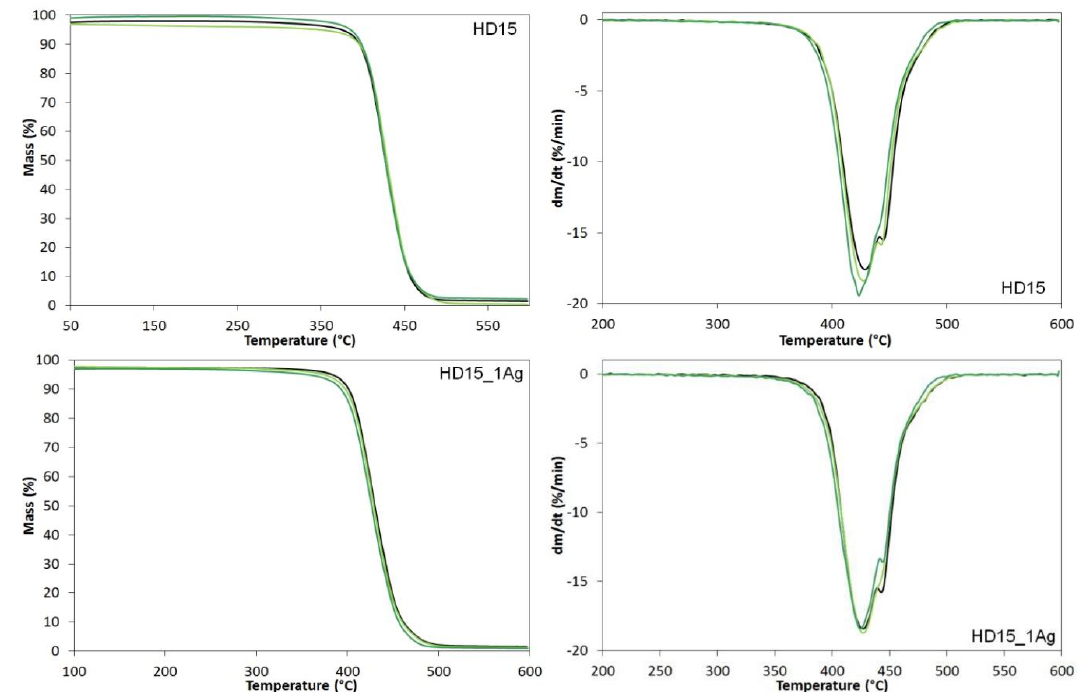
Figure 11. Thermogravimetric (TG) and derivative thermogravimetric (DTG) curves of pure polymer (HD15) and polymer containing 1.0 wt % of silver nanoparticles AgNPs before incubation (black line), after 12 months (light green line) and after 24 months of incubation (dark green line).